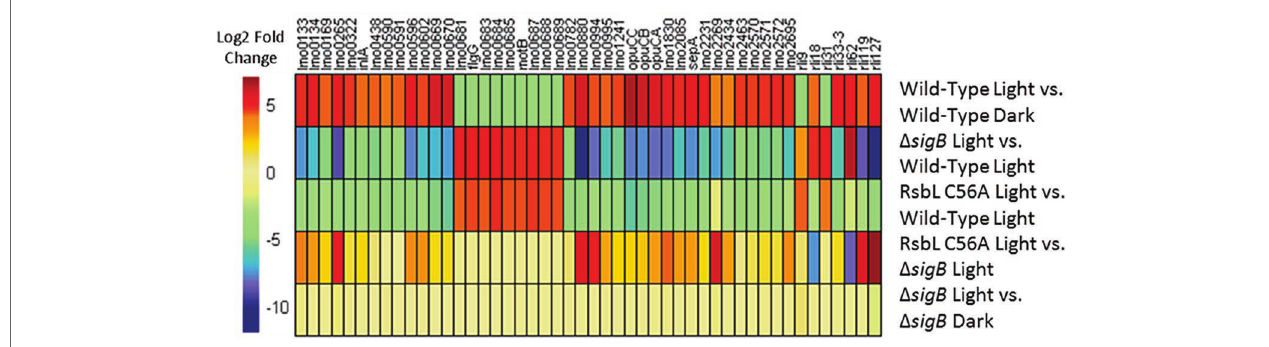
FIGURE 6 | SigB is required for the altered transcription of 98% of genes showing a greater than 16-fold change in transcription in response to visible light. Genes showing a greater than 16-fold change in transcription in the wild-type in response to visible light were selected. All genes except for rli18 and rli62 require SigB to significantly alter their transcription in response to visible